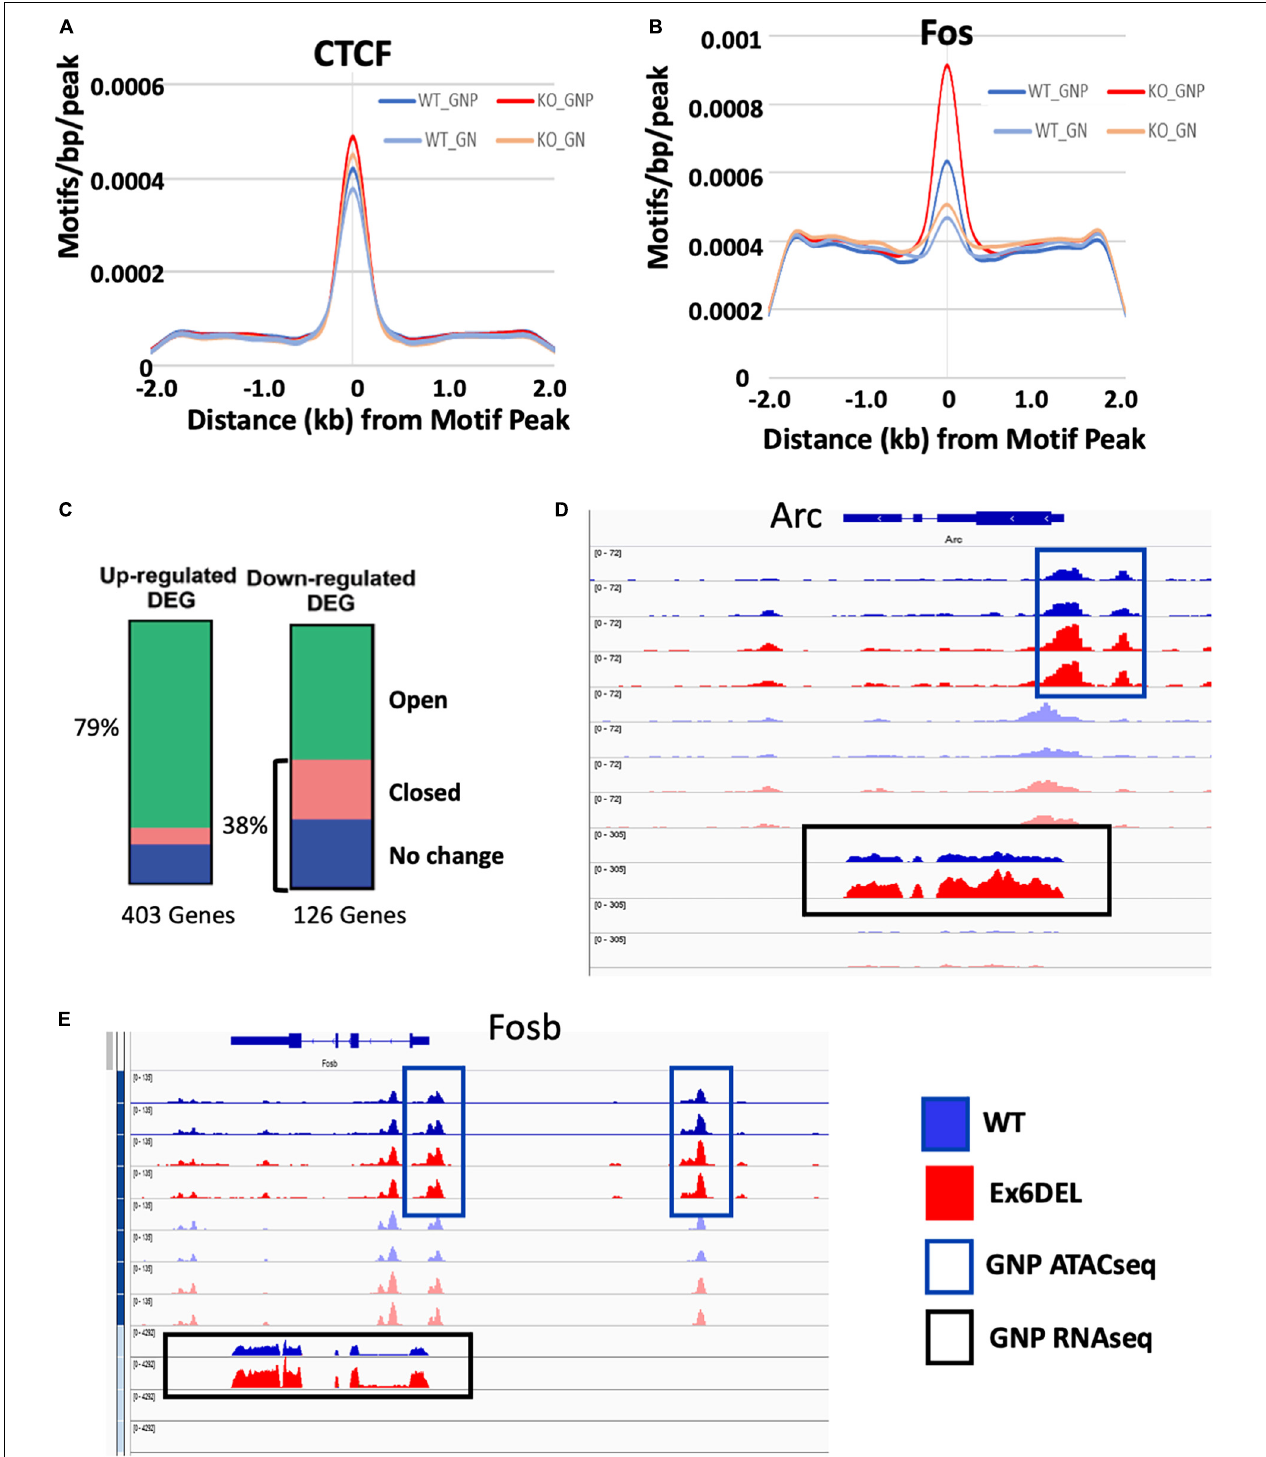
FIGURE 5 | Accessible regions are enriched for Fos/Jun binding sites. ATACseq peak alignment with binding sites for CTCF (A) or Fos (B) showed enrichment in the Ex6DEL samples for Fos binding sites but not CTCF. (C) ATACseq peaks at 1 DIV were assigned to the nearest gene and then cross referenced to the up- and down-regulated genes to generate the bar graphs. Open (green) closed (pink) or chromatin regions showing no change (blue) are shown. (D,E) ATACseq and RNAseq reads shown in IGV browser format for the Arc (D) and Fosb (E) genes. The GNP ATACseq tracks are shown in the blue box. The GNP RNAseq is shown in the black box. The unboxed tracks correspond to ATACseq and RNAseq from GNs.